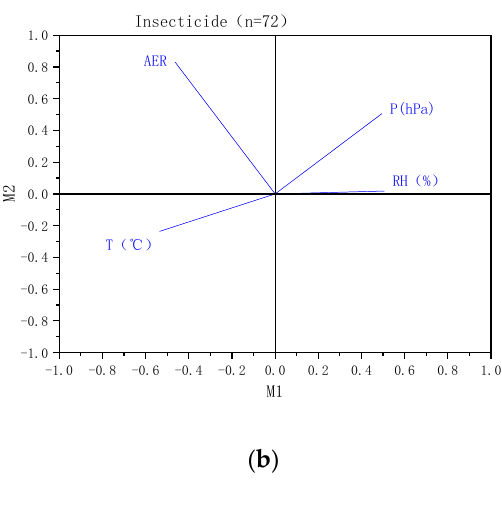
Figure 7. Relationship between AER of insecticide and air pressure. As the relativity among different meteorological elements existed to some extent, to describe the impact of a single element on insecticide volatilization with their respective correlations was difficult. Therefore, the principal component analysis method was used to probe the correlation between various factors in the test data. Principal component analysis was performed on the test elements according to the above classification (Fig- ures 5 – 7). According to the principal component analysis of various elements in different classifications(Figure 8a,b), the eigenvalue of the major principal component (M1) were all greater than three, while the eigenvalues of other principal components were all less than one, which indicates that M1has included most of the information of factors. The correlation statistics between M1 and AER exhibited a good linear correlation (Figure 8c). There were 72 samples in-all of insecticides in the test. The complex correlation coeffi- cient R 2 of the AER measured in the test with air temperature, relative humidity and air pressure were 0.568, 0.529 and 0.434 respectively. The M1 was linearly correlated with the AER, and R 2 equals 0.719.